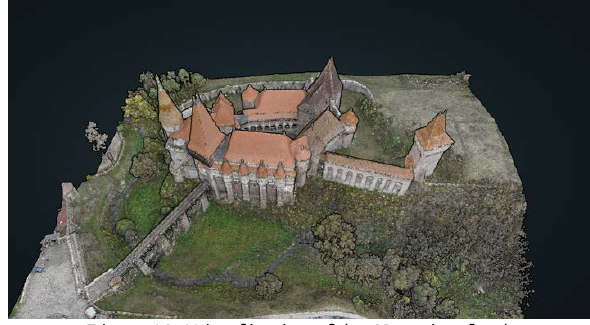
Figure 12. Visualization of the 3D point cloud